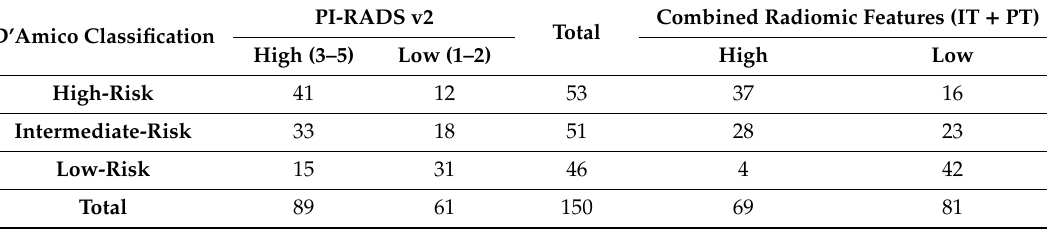
Table 2. Risk stratification results of PCa lesions for PI-RADS v2 and radiomics, based on D’Amico Risk Classification System (DRCS) criteria (Low-versus-(Intermediate + High)